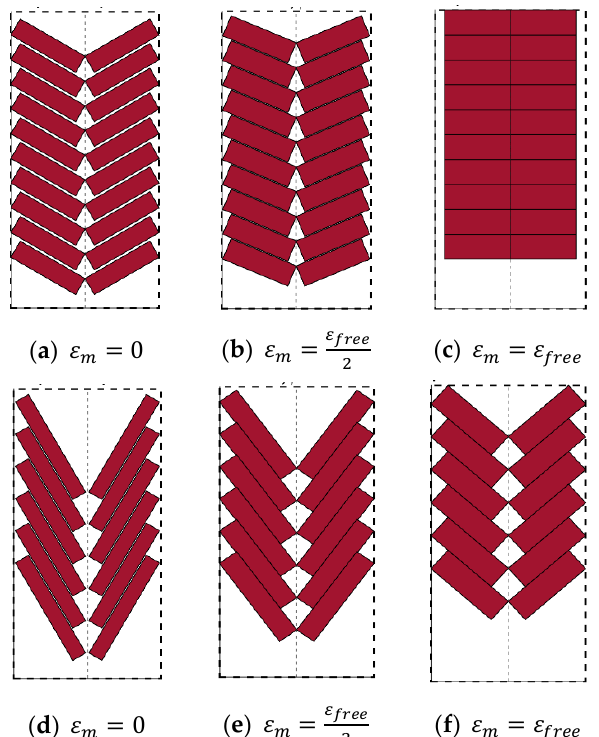
Figure 3. Two-dimensional visual representation of fiber behaviors during muscle contraction from zero muscle strain ε m to muscle strain at free contraction ε free . Each image shows a snapshot of the fiber dimensions and orientation at a stage of muscle strain. Images in the top row ( a – c ) illustrate the rotation-limited bipennate configuration ( β i = 60 ◦ ), and the images in the bottom row ( d – f ) illustrate a contraction-limited configuration ( β i = 60 ◦ ). The planar view of the bounding envelope is indicated by the black dashed lines.